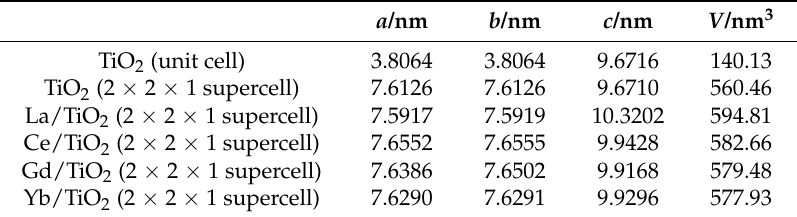
Table 2. Lattice parameters of rare-earth-doped anatase TiO 2